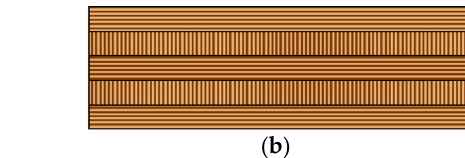
( c ) Figure 3. Airborne noise source ( a ), tapping machine ( b ) and rubber ball ( c ). An omnidirectional source with twelve loudspeakers (airborne source) driven with a pink noise signal, a standard tapping machine and a rubber ball have been used, respec ‐ tively. In particular, the rubber ball is useful for a low frequency analysis. The tapping machine is the one most used both in the study of bare structures and in the case of the application of additional layers [60]. The three sources above described are illustrated in Figure 3.